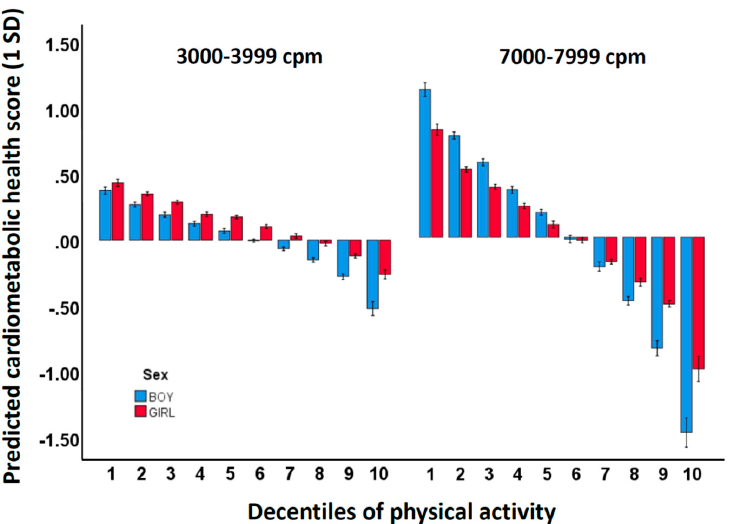
Figure 2. The predicted change in cardiometabolic health as compared to the average physical activity level in the various decentile groups.